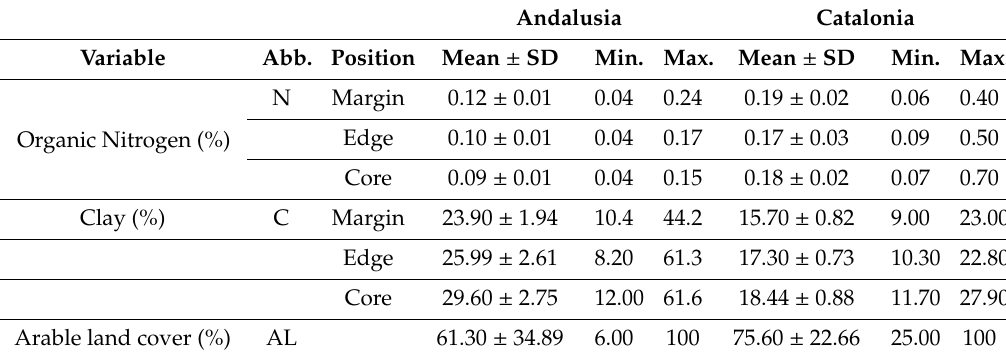
Table 1. Categories or mean ± standard deviation (SD), minimum and maximum values of the independent variables included in the analyses. Values are separated for the cereal fields sampled in Andalusia (23) and Catalonia (24). Abb. Abbreviation used in the main